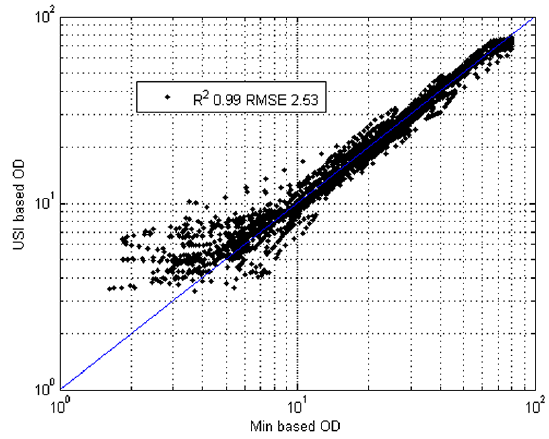
Figure 15. Comparison of RRBR τ c retrievals from the sky imager vs. the Min et al. (2003) method applied to MFRSR measurements for USI cloud fractions greater than 0.7. USI results are averaged in irradiance space over the hemisphere as shown in Eq.